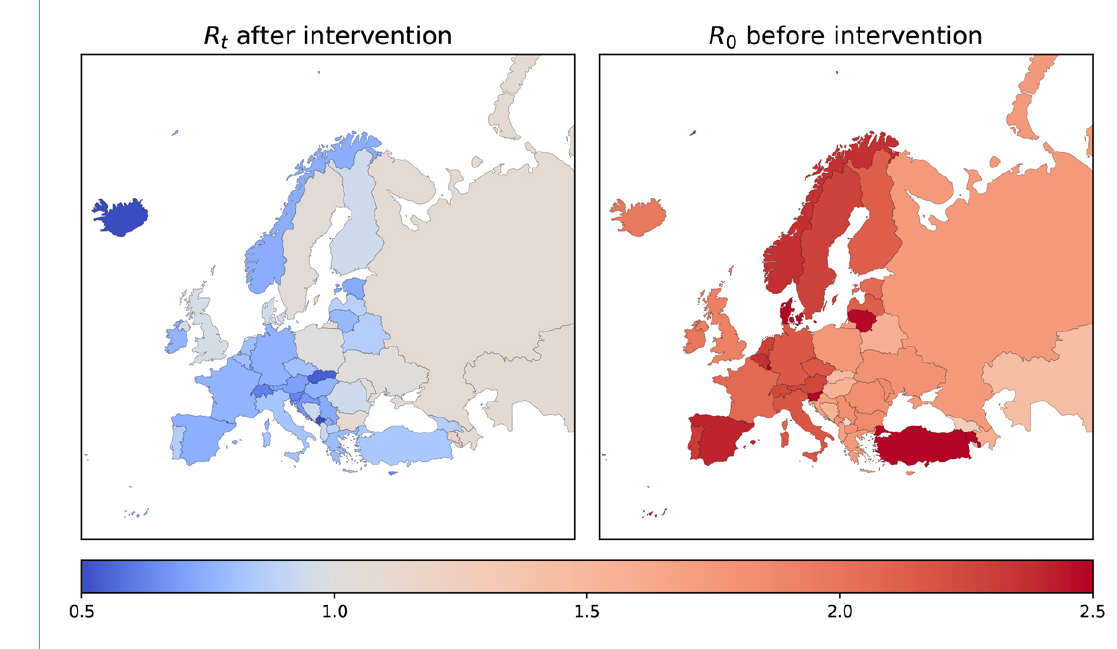
Figure 4: Inferred reproduction number R t before (right) and after interventions (left) shown in color on a map of Europe